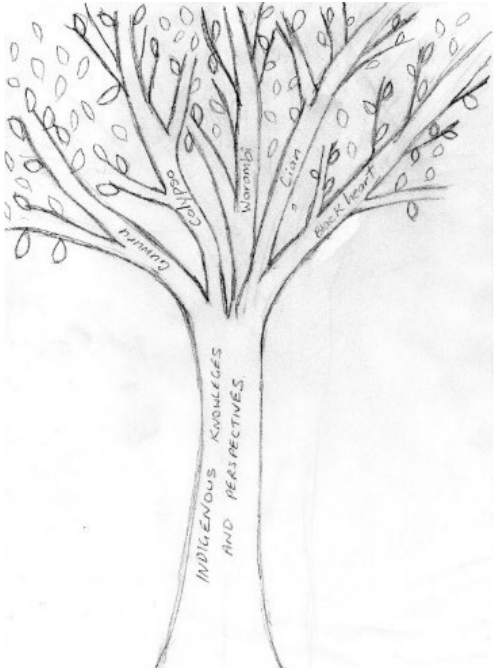
Figure 1. Research